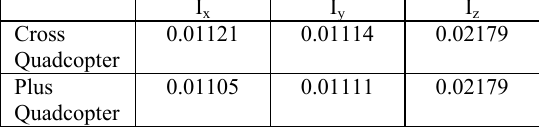
Table 3. The obtained PID gains